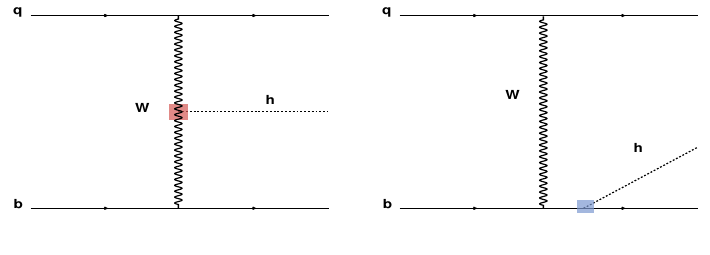
Figure 2 . Feynman diagrams contributing to thX production with X = j